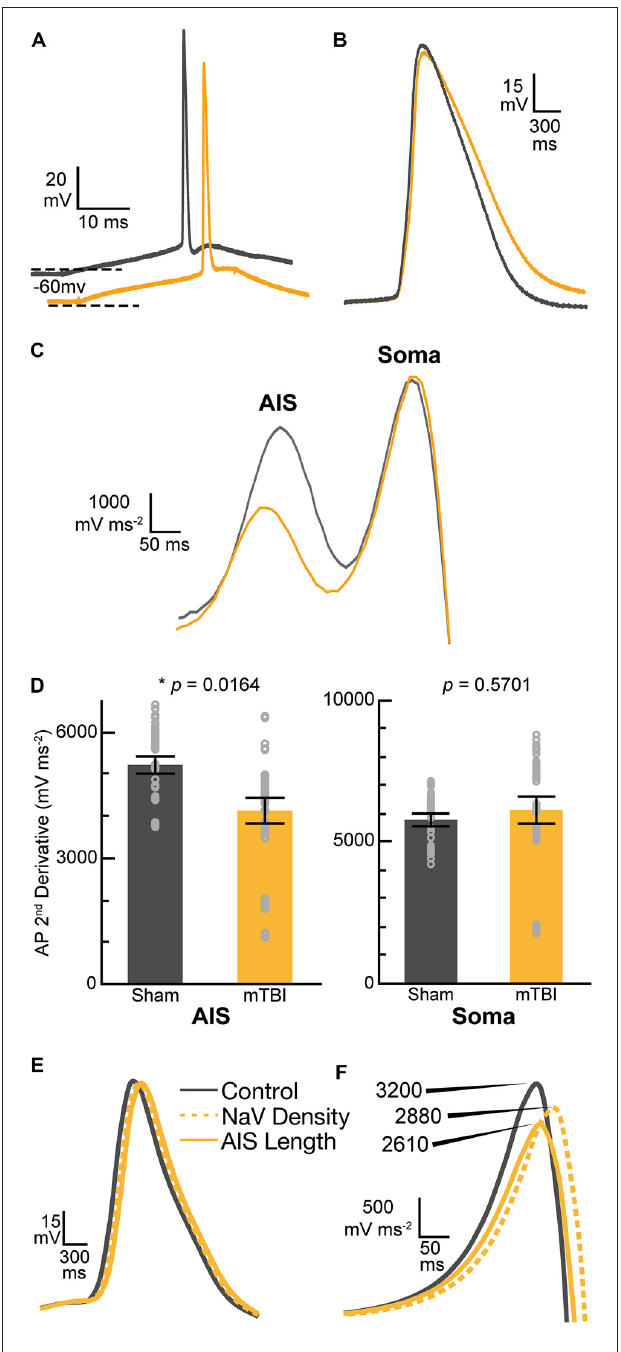
FIGURE 10 | Action potential (AP) acceleration at the AIS is reduced 2 days post-mTBI. (A–D) Whole-cell patch-clamp analysis of intact YFP+ pyramidal neurons of layer 5 primary somatosensory barrel field (S1BF) in sham (gray) and mTBI (gold) ex vivo live slices. (A) Representative traces of AP recorded at somas. The mTBI trace is offset for better comparison. Dashed lines indicate holding potential. (B) Enlarged traces from (A) showing AP waveform. Note slightly longer AP decay after mTBI. (C) Plot of second derivative of the membrane voltage. The first and second peak amplitudes were used to compare AP acceleration at the AIS and soma, respectively. (D) Multilevel analysis of the second derivative of membrane voltage (AP acceleration)